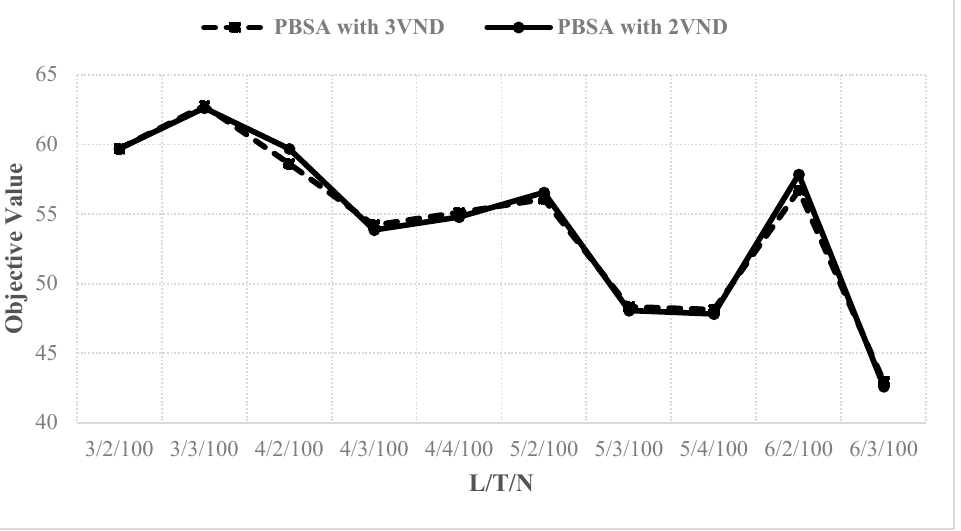
Figure 5. Impacts of the numbers of production lines and scheduling days. Figure 8. Impacts of the numbers of production lines and scheduling